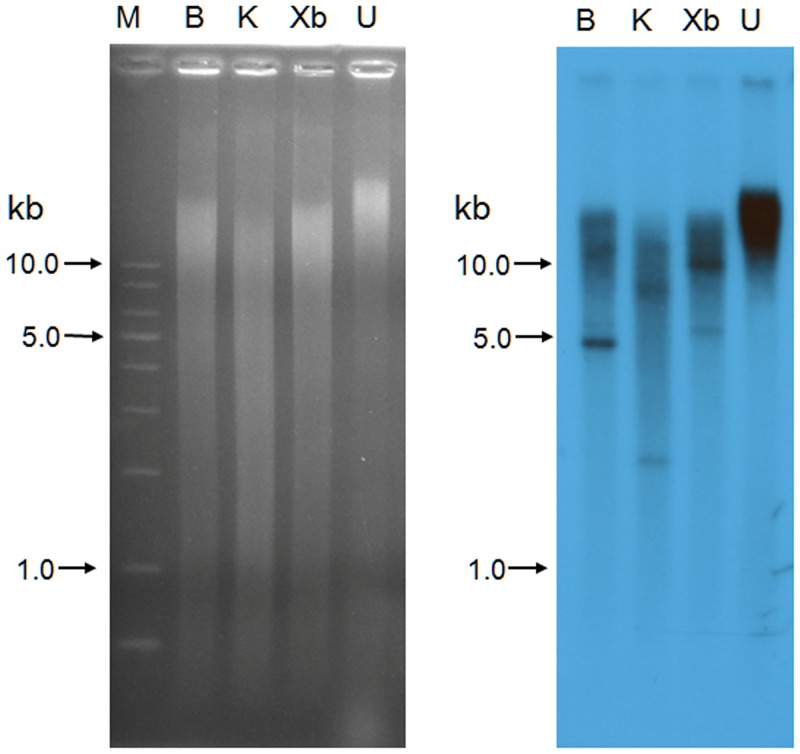
Southern blotting of Chloromonas genomic DNA to analyze the gene family encoding ChloroIBP.Left: Ethidium bromide-stained agarose gel showing: M, 1 kb DNA ladder; B, BamHI-digested Chloromonas genomic DNA; K, KpnI-digested Chloromonas genomic DNA; Xb, XbaI-digested Chloromonas genomic DNA; U, Undigested nuclear DNA as a control. Right: Autoradiogram of the probed blot from the gel on the left.